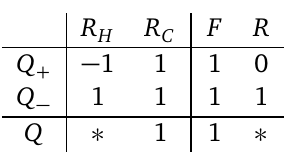
Table 1: Summary of supercharges weights under R -symmetry generators in the A -